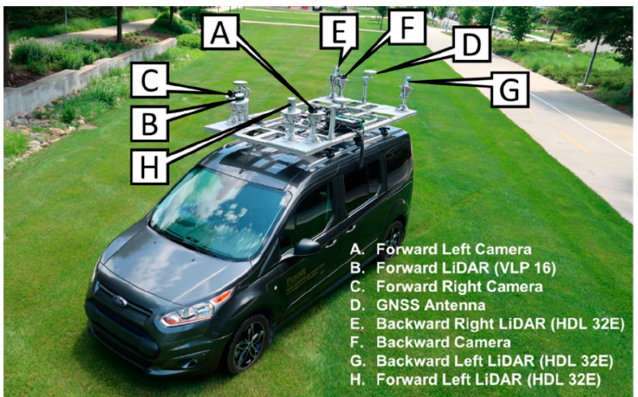
Figure 1. The mobile mapping system Purdue Wheel-based Mobile Mapping System-High Accuracy (PWMMS-HA) used in this research.